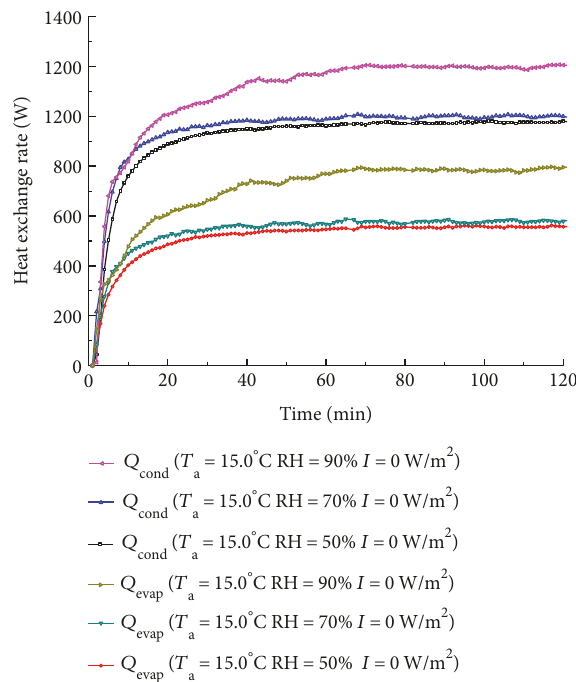
Figure 10: Variation of the evaporating and condensing heat exchange rate with the relative humidity of 50%, 70%, and